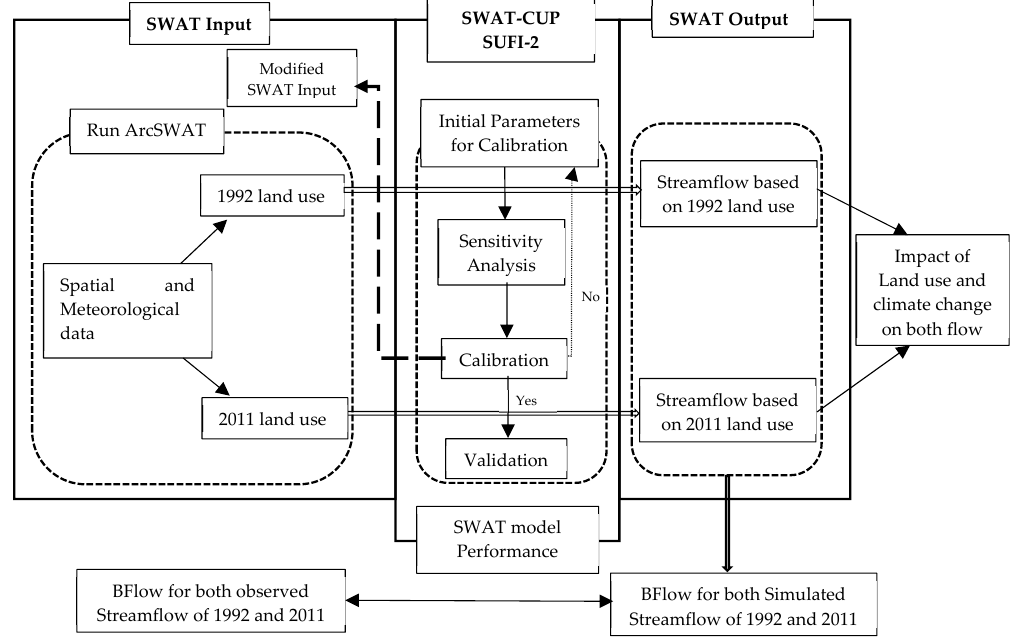
Figure 2. Flow chart showing the methodology used in this study (modified from Aboelnour et al. [8]).